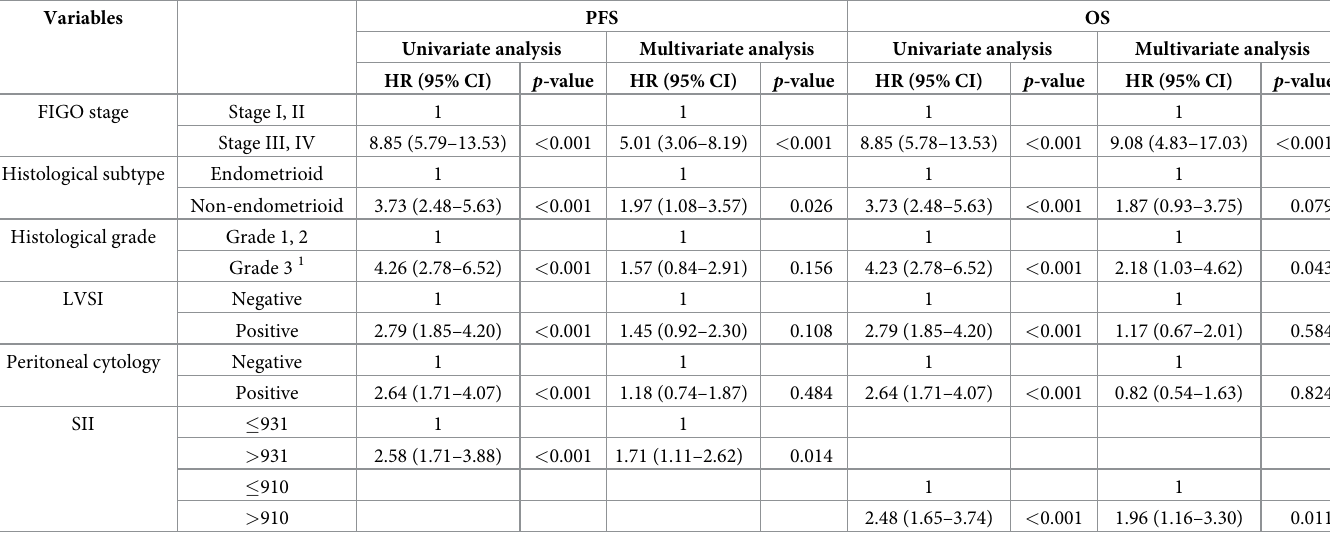
Table 3. Result of univariate and multivariate cox regression analysis for progression free survival and overall survival in endometrial cancer. Variables